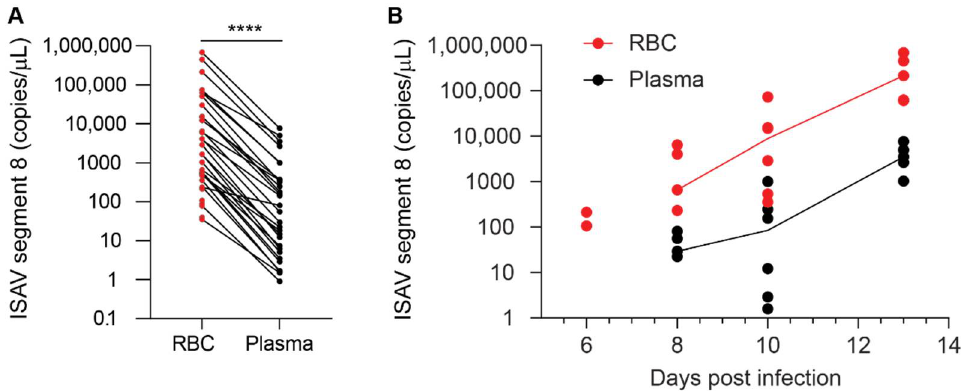
Figure 4. ISAV is enriched in the cellular fraction of blood. qPCR of density gradient-purified erythrocytes (RBC, shown in red) and plasma (black) from individual fish in the 2020 trial showing ( A ) the relationship between ISAV mRNA in RBC and plasma in all individual fish and ( B ) the relationship of ISAV mRNA in RBC and plasma over the time course of the experimental infection. Dots represent individual fish. ( A ) Lines connect values from the same fish. **** p < 0.0001, Wilcoxon matched-pairs signed rank test. ( B ) Lines connect median values within each group. The values on the y -axis have been adjusted for the difference in the sampled volume of RBC and plasma.